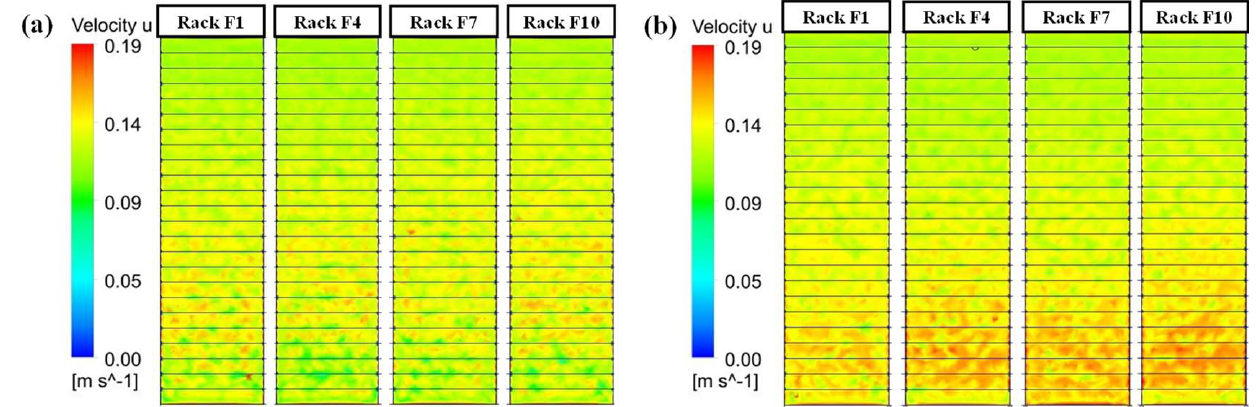
Figure 14. The exhaust air velocity distribution: ( a ) without terminal device; ( b ) with terminal device.